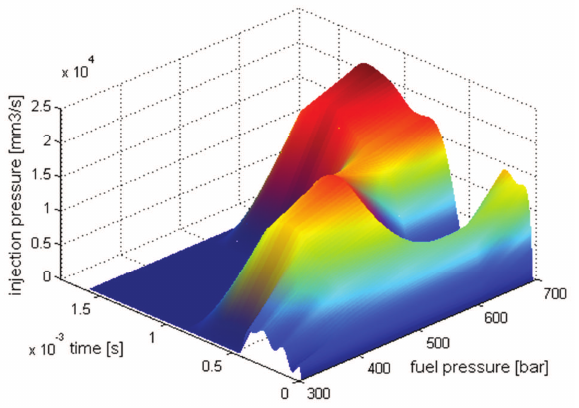
Fig. 4. Changes in parameters and forms of injection of two-portion dose (first measuring group)